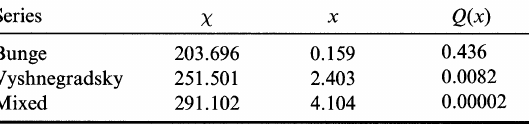
TABLE VI X hypothesis tests for ruble data. The empirical series include n=998 observations histogrammed in u=201 bins. The reduced variable x* corresponding to the 0.05 con- fidence level, i.e., Q(x*)=O.05, is